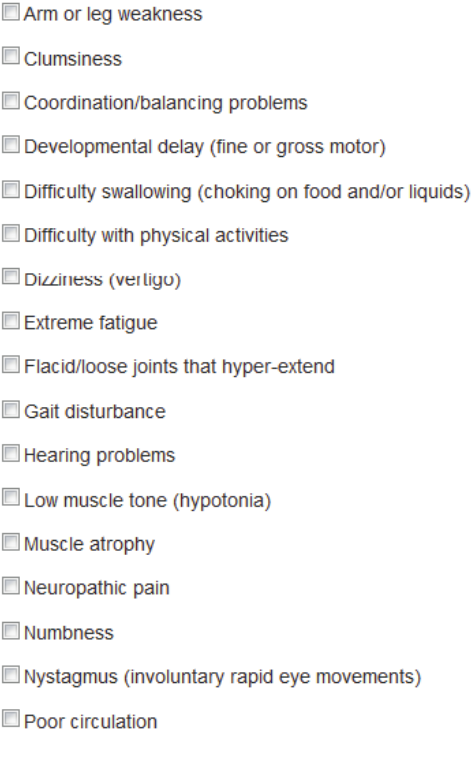
Supplemental Figure 4.